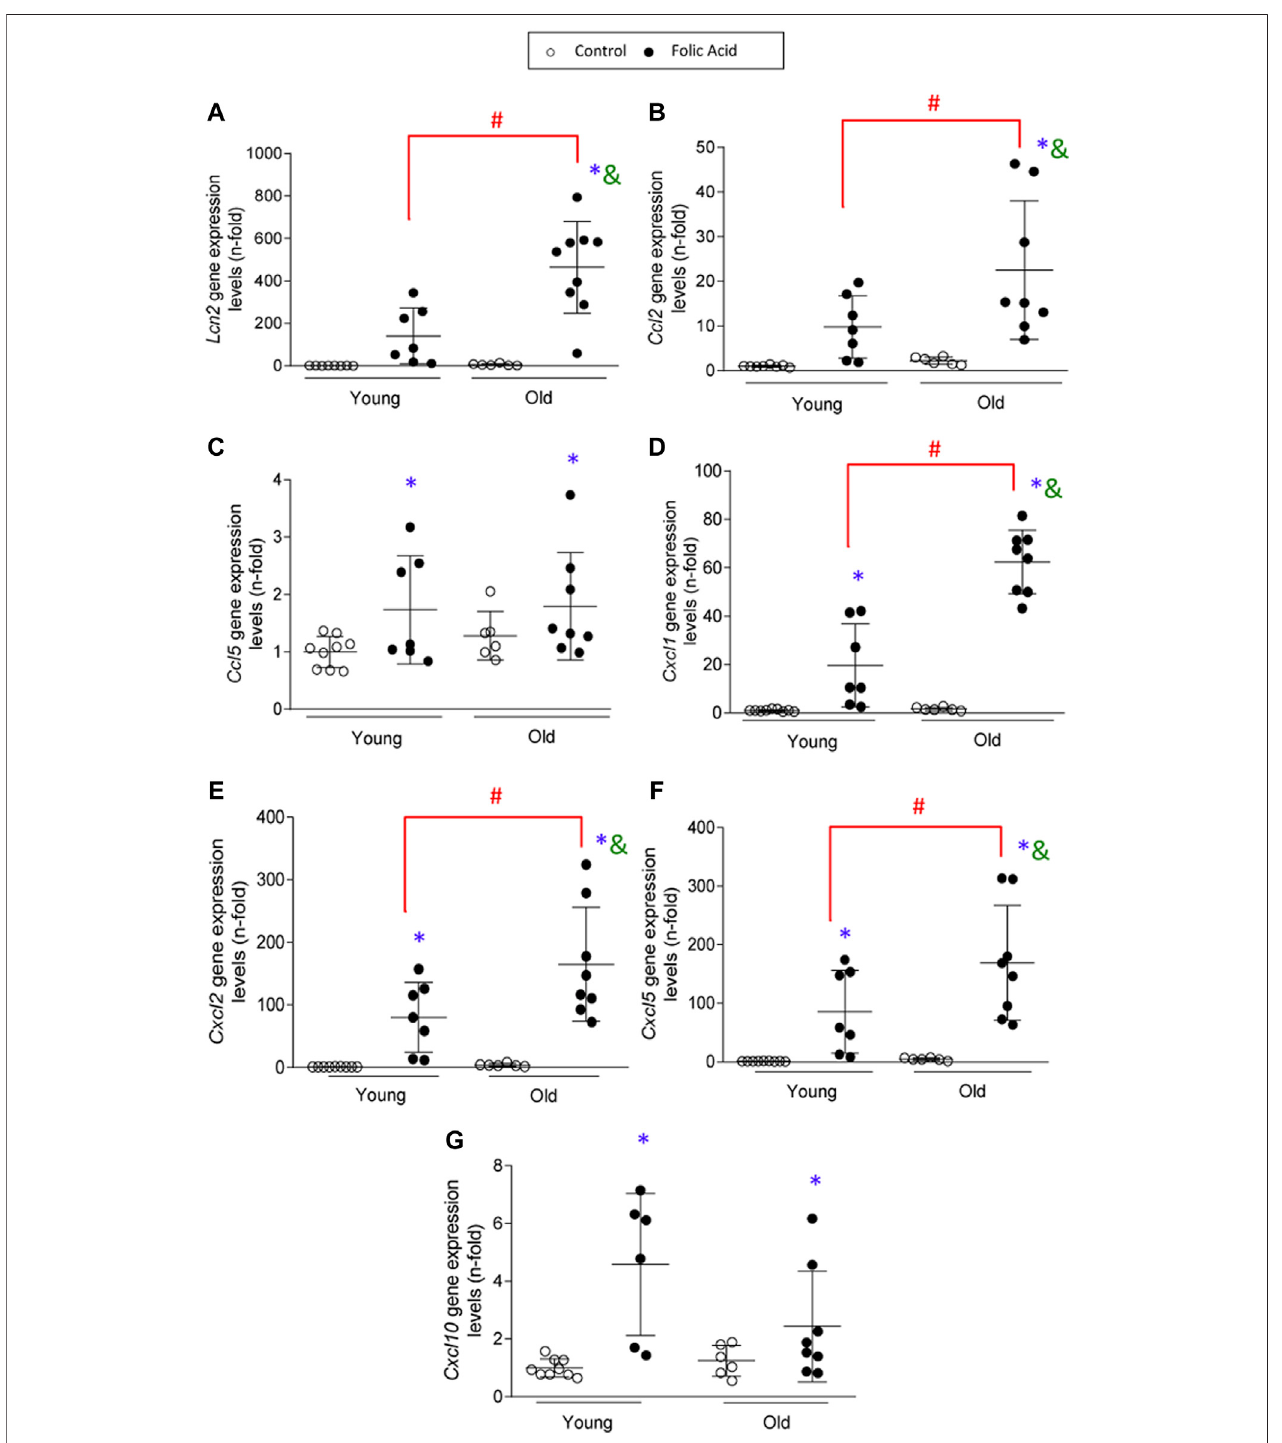
FIGURE 4 | Kidney expression of proin fl ammatory genes in the acute phase of folic acid (FA) nephropathy in young and old mice. Folic Acid (FA; 125 mg/kg) was injected in 3-months-old (Young) and 1-year-old (Old) C57BL/6 mice. Kidneys were studied after 48 h and qRT-PCR was performed to assess Lcn2 (A) , Ccl2 (B) , Ccl5 (C) , Cxcl1 (D) , Cxcl2 (E) , Cxcl5 (F) , and Cxcl10 (G) gene expression levels. Data are shown as n-fold and expressed as mean ± SD of n (cid:2) 6 – 9 animals per group. * p < 0.05 vs. control young mice, # p < 0.05 vs. FA-injected young mice, & p < 0.05 vs. control old mice. The parametric one-way ANOVA statistical test was